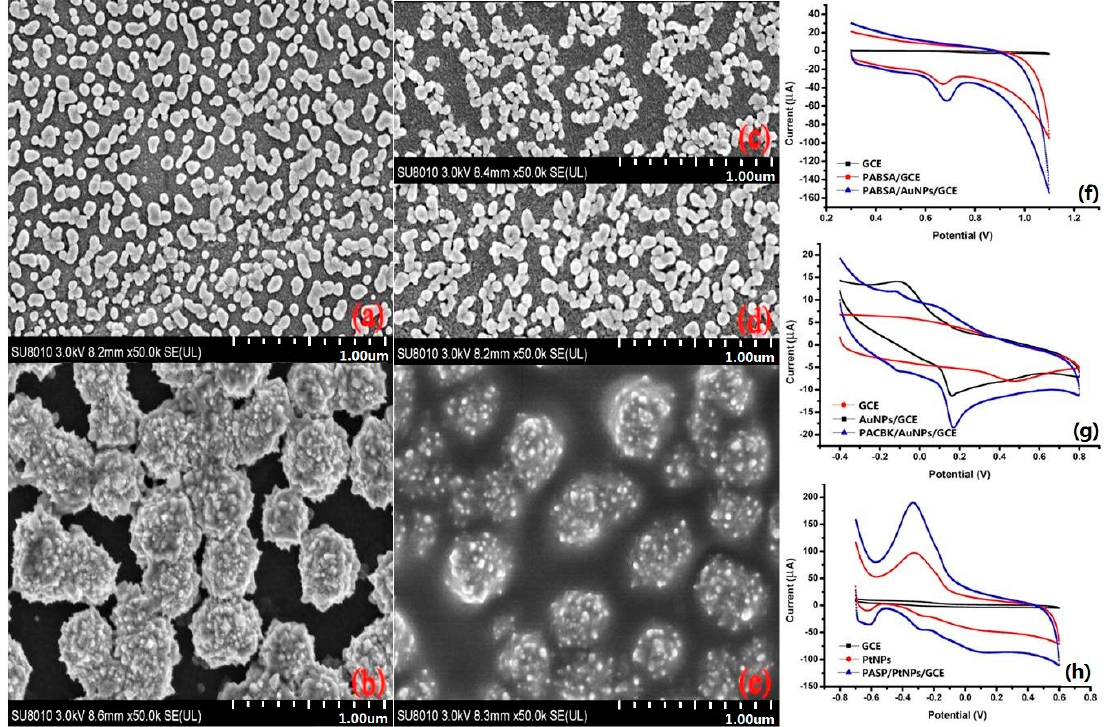
Figure 3. SEM images of AuNPs film ( a ), PtNPs film ( b ), PABSA/AuNPs film( c ), PACBK/AuNPs film ( d ), and PASP/PtNPsfilm ( e ); CV behaviors of Tyr ( f ), AA ( g ), and Glu ( h ) on the raw GCE and modified electrodes.